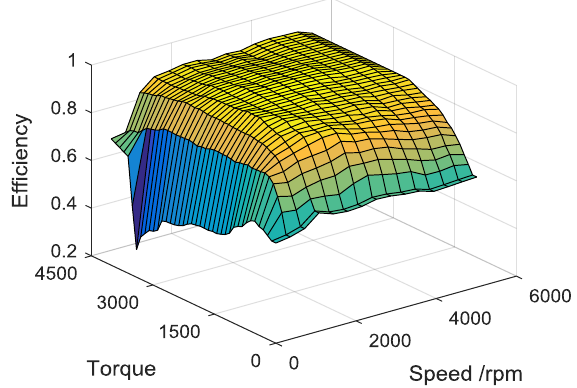
Figure 6. The motor efficiency map. Energies 2018 , 11 , x FOR PEER REVIEW